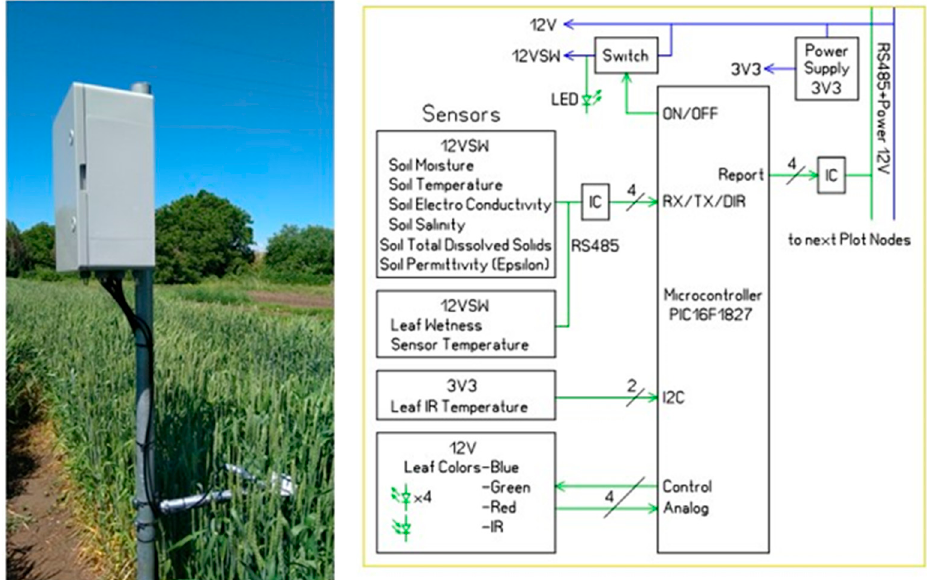
Figure 4. Experimental setup: picture (left) and fl owchart (right).